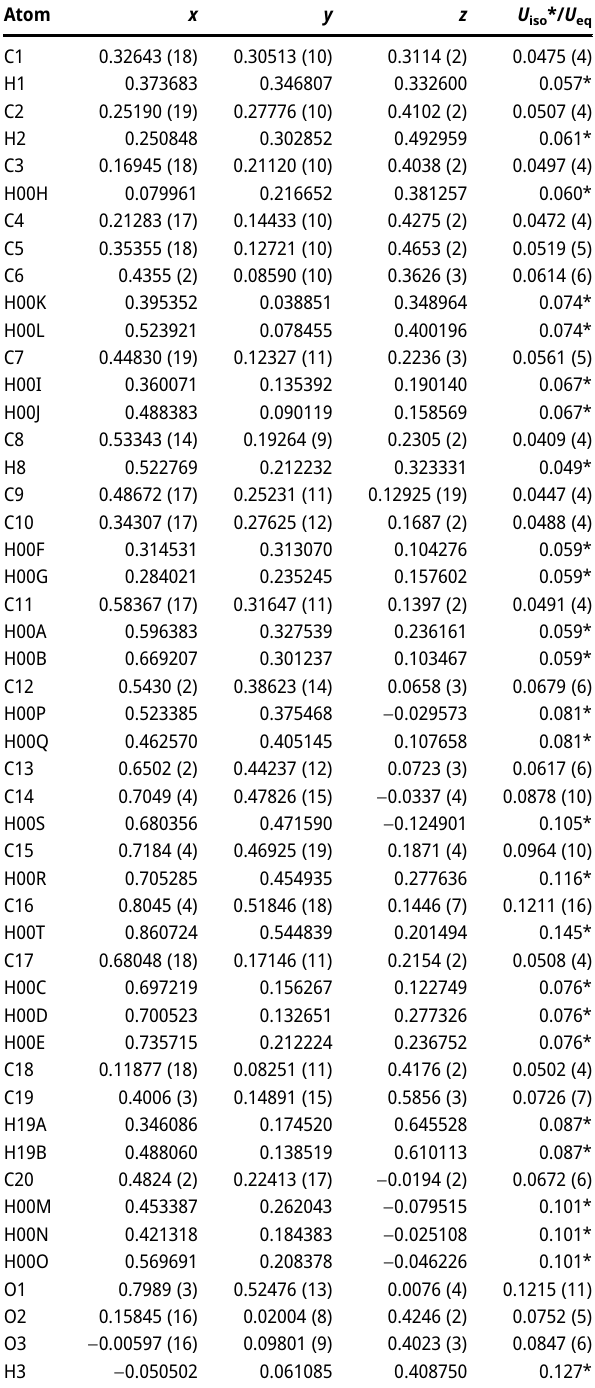
Table  : Fractional atomic coordinates and isotropic or equivalent isotropic displacement parameters (Å 